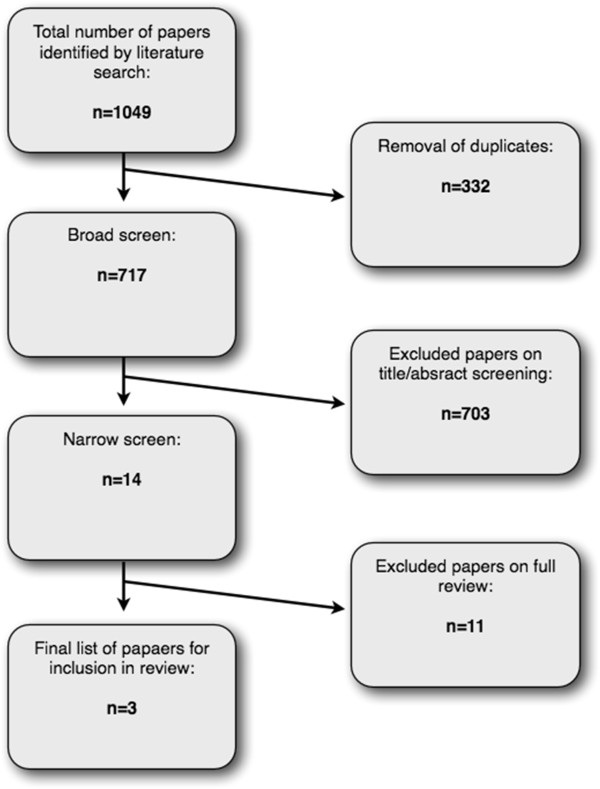
Search results flow diagram.